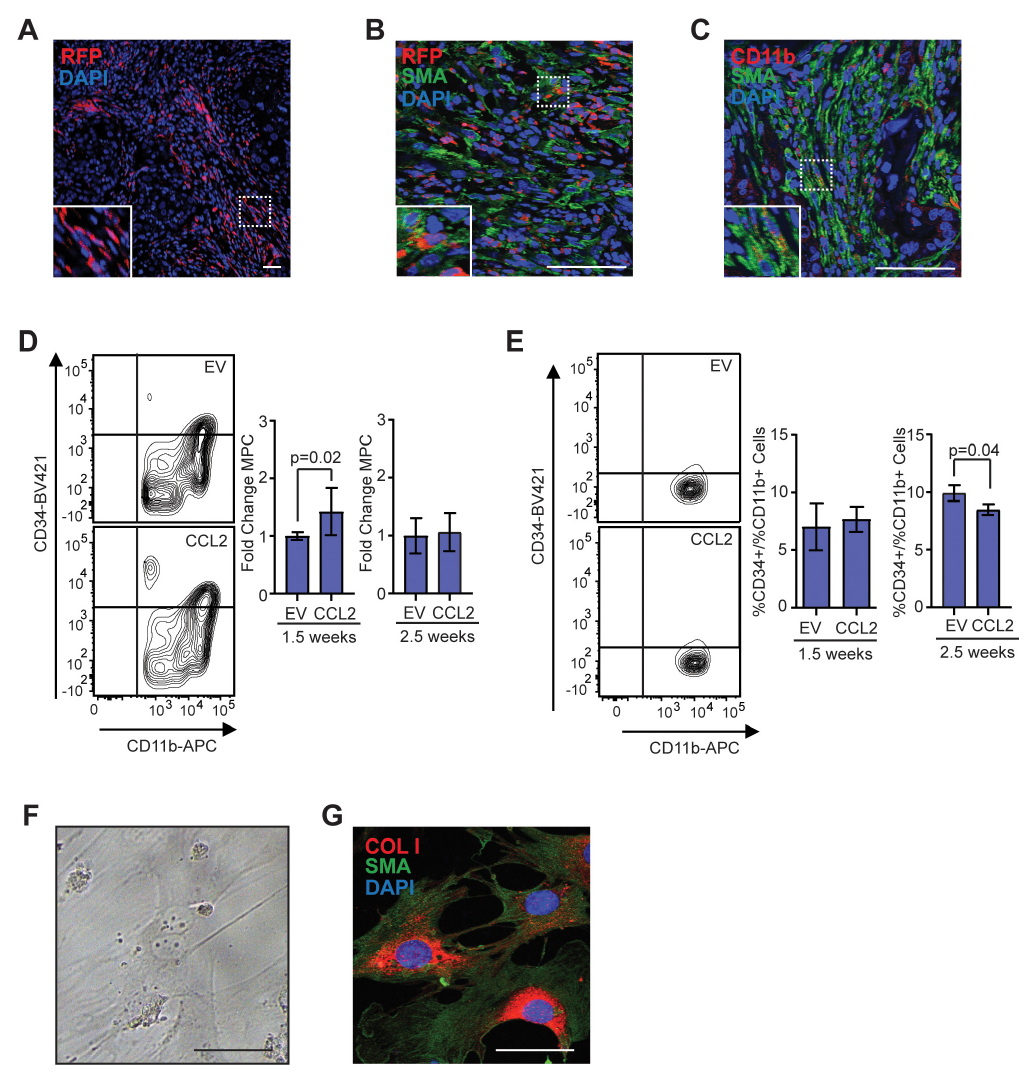
Figure 4. Population of CD11b + myeloid progenitor cells di ff erentiate into SMA + stromal cells within tumors and in vitro. ( A ) Representative image of red fluorescent protein (RFP) + stromal cells in tumor from CCR2-RFP heterozygous SCID mouse. ( B ) RFP + SMA + double positive cells within tumor stroma. ( C ) CD11b + SMA + double positive cells within tumor stroma. ( D ) CD45 + CD11b + CD34 + myeloid progenitor cells in the mammary gland at 1.5 ( n = 5 empty vector (EV), 7 CCL2) and 2.5 weeks ( n = 5